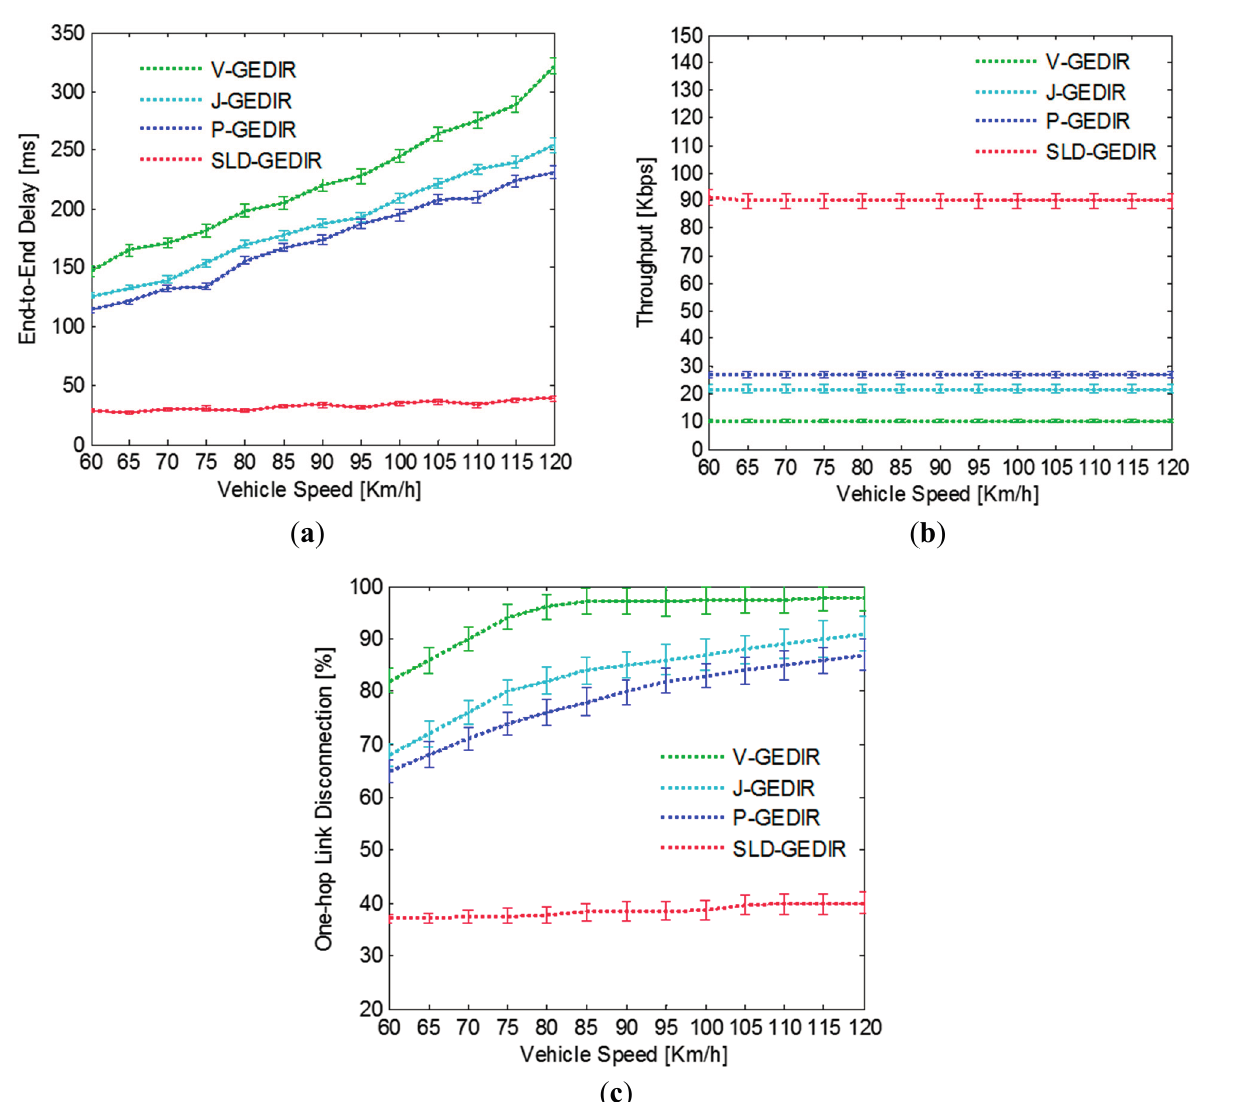
Figure 14. Map-based analysis ( a ) end-to-end delay; ( b ) throughput and ( c ) One-hop link